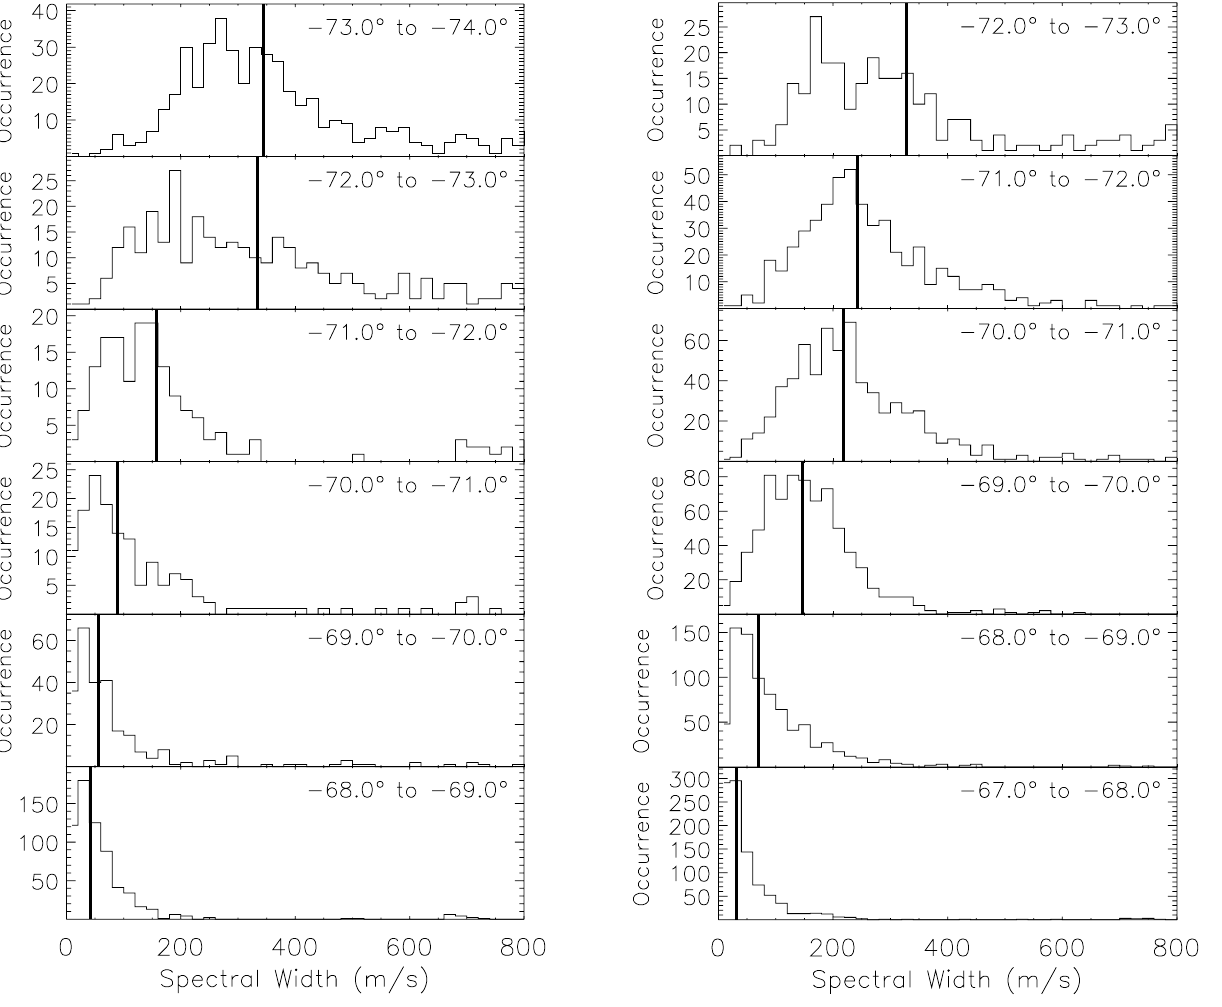
Fig. 5. The distributions of spectral width from all beams of the Halley radar measured during the interval 14:48–15:15 UT (interval C) on 14 August 1998. The distributions have been split into 1 ◦ latitude bins from − 67 ◦ to − 73 ◦ . The bold vertical lines represent the medians of each